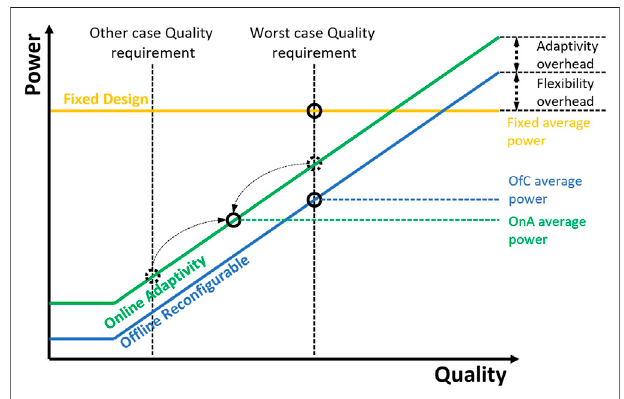
FIGURE 4 | Trade-offs of fi xed vs. OfC vs.